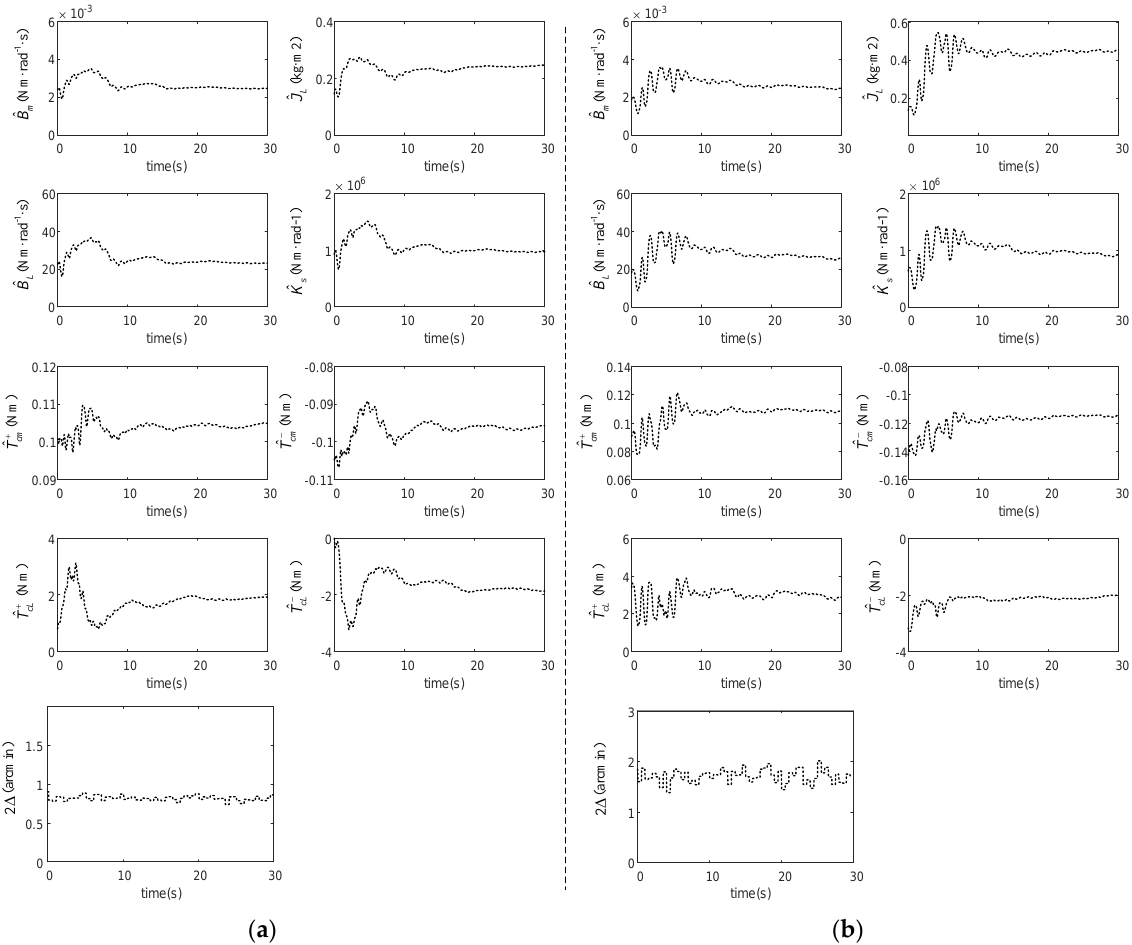
Figure 6. Convergence process of multi-parameter online identification in the experiment. ( a ) Without load; ( b ) With